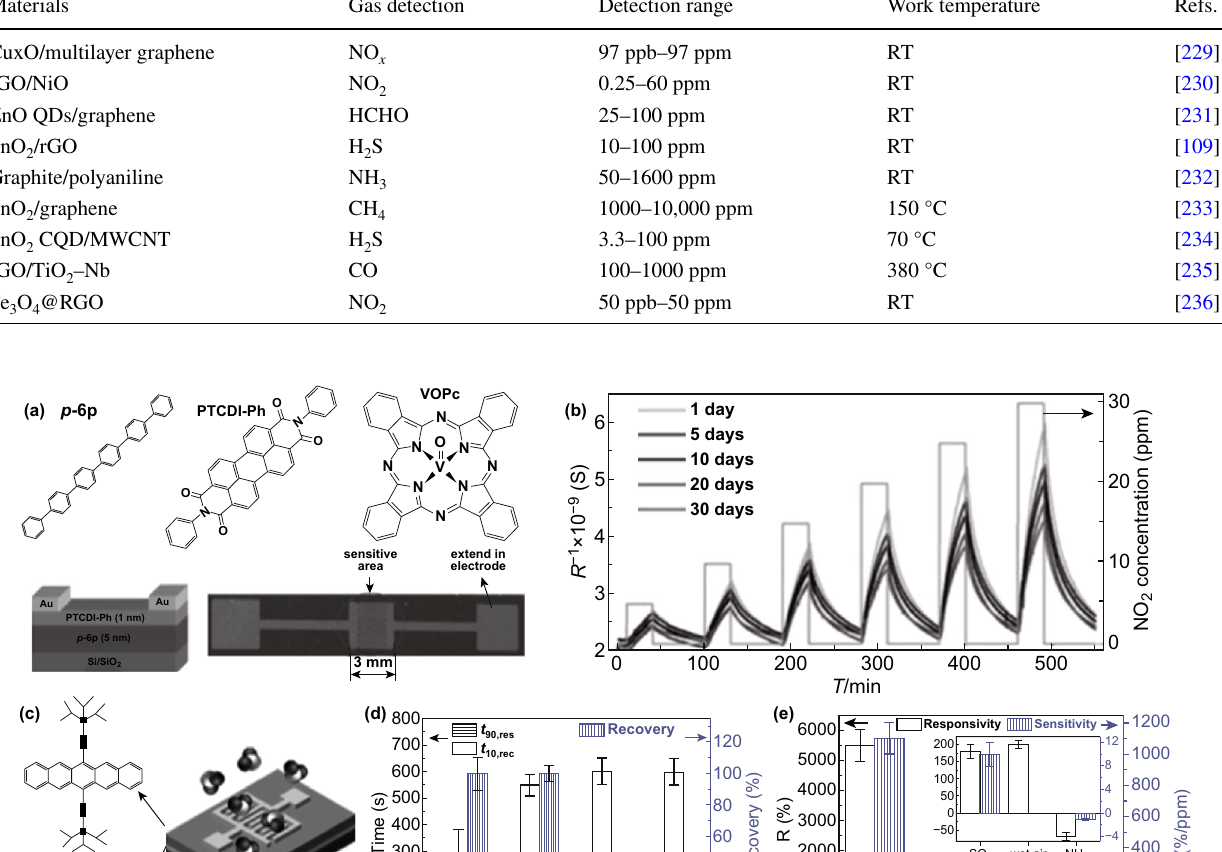
Table 2 Representative works based on charge transfer effects Materials